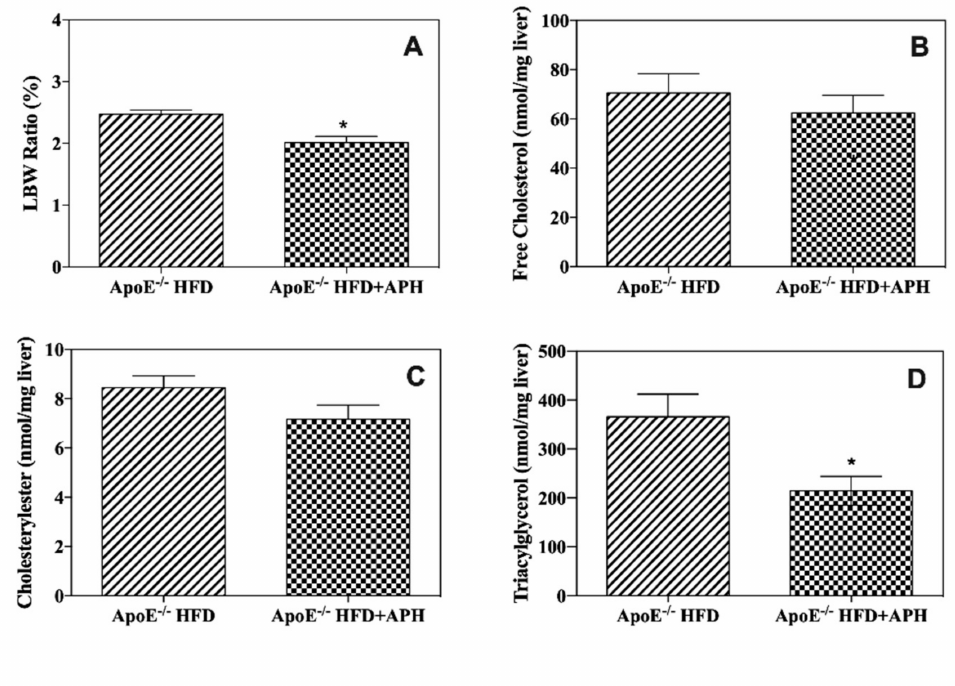
Figure 2. Liver-to-body weight ratio (LBW) ( A ) and levels of hepatic free cholesterol ( B ) cholesteryl ester ( C ) and triacylglycerol ( D ). LBW in ApoE – / – mice fed with HFD was significantly increased (i.e., 2.47%) compared to ApoE – / – mice fed with HFD + APH (i.e., 2.01%) ( p < 0.0001). No statistical di ff erence was found in either hepatic free cholesterol ( B ) or cholesteryl ester ( C ), whereas hepatic triacylglycerol ( D ) content was significantly reduced in ApoE – / – mice fed HFD + APH (214.39 ± 29.67 nmol / mg) compared to values obtained from ApoE – / – control mice fed HFD (365.97 ± 46.20 nmol / mg). Data are presented as mean ± SD for n = 6 mice per group. Abbreviations: HFD, high-fat diet, APH, anchovy protein